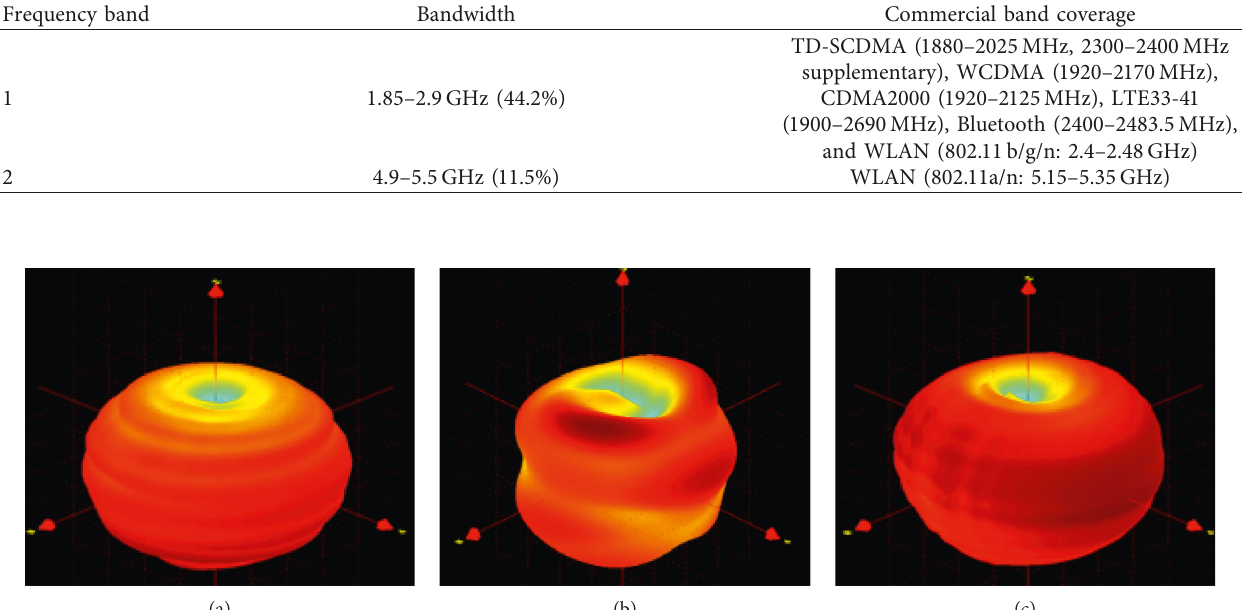
Figure 10: Measured and simulated S11 of the antenna. Table 3: Measured frequency bands of the antenna.